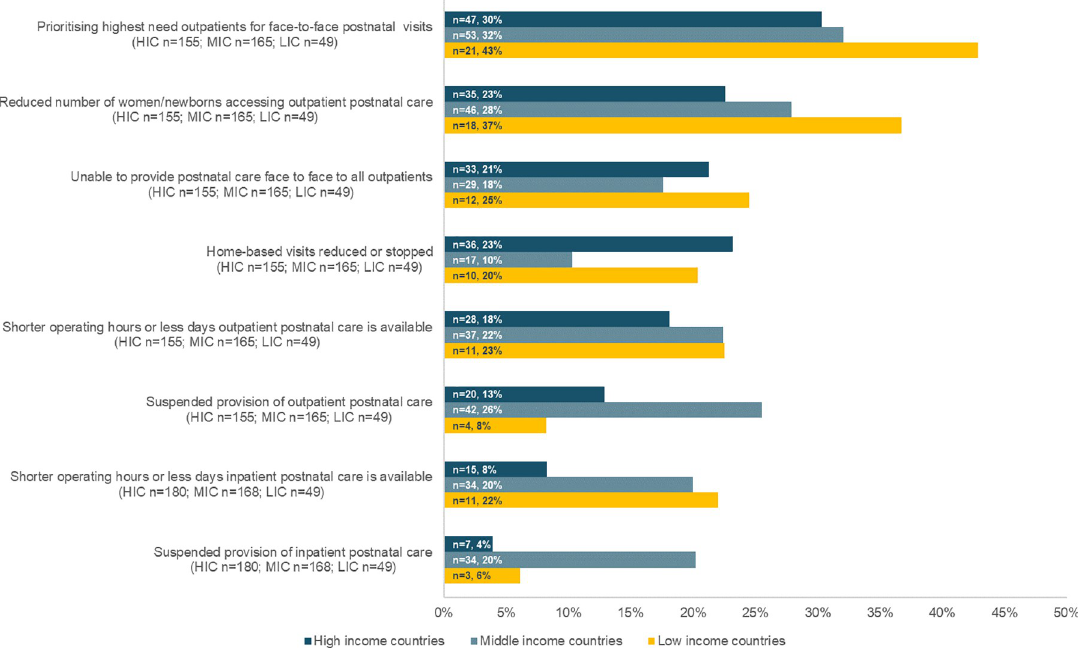
Fig 3. Number and percentage of respondents reporting changes in postnatal care use and provision and service availability, by country income level during the month preceding the survey.